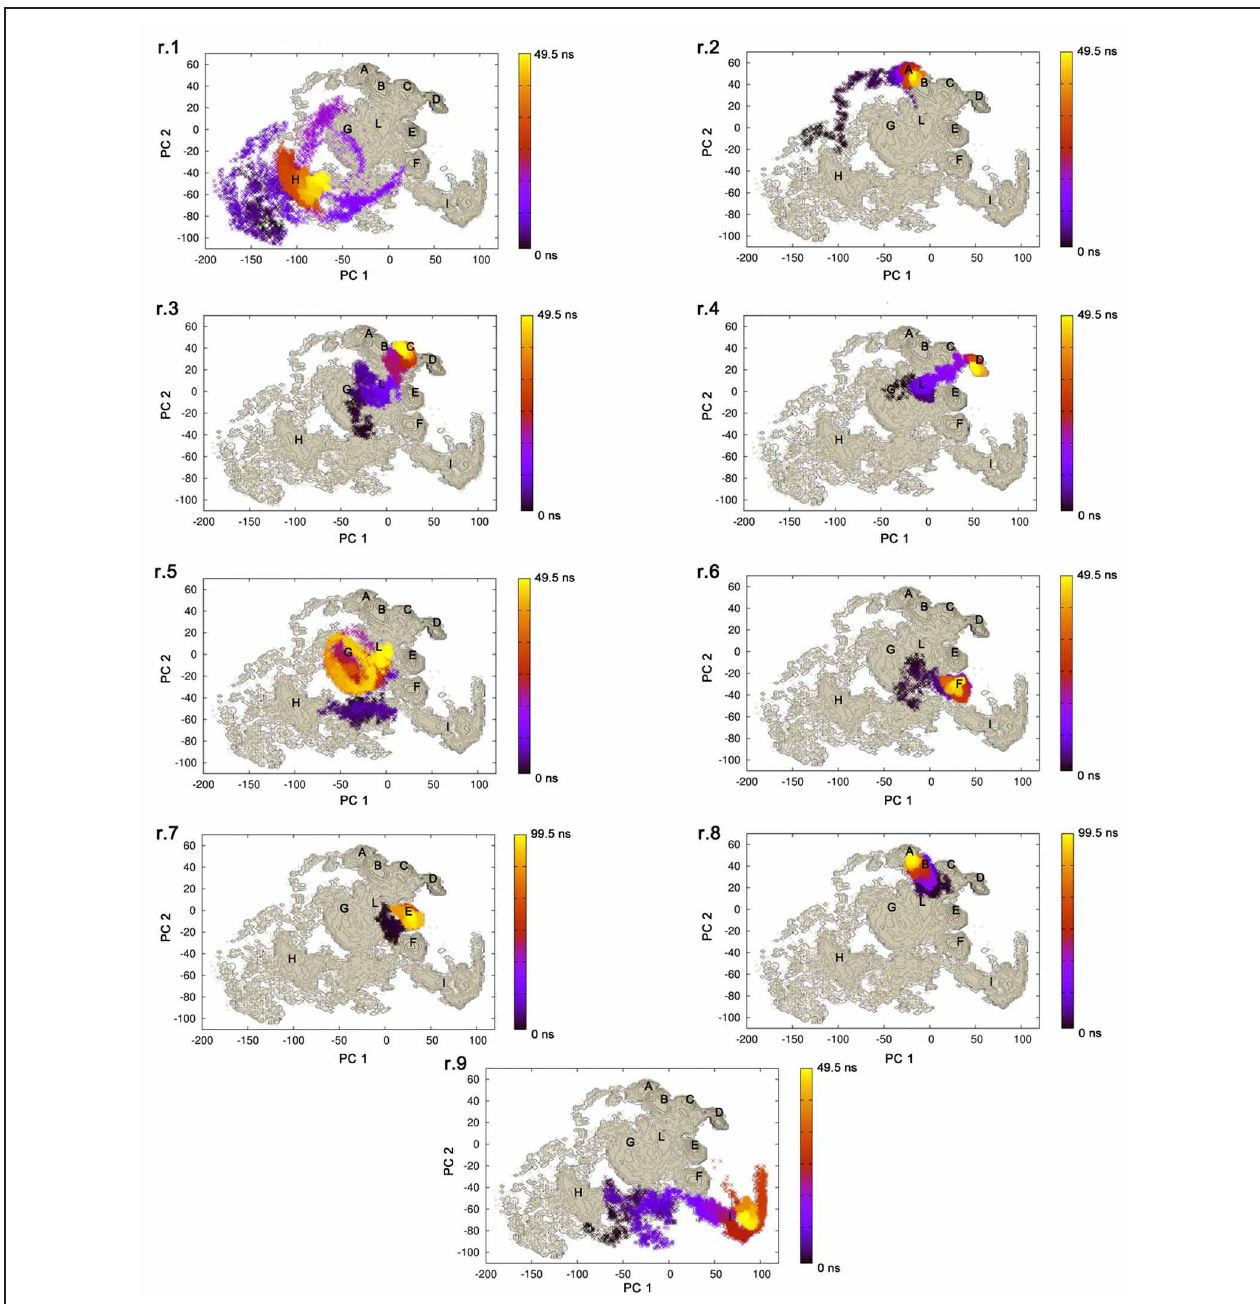
FIGURE 6 | Projection of the single replicate on the FEL. The trajectories explored by each replicate are depicted on the FEL representation obtained using the first two PCs as reaction